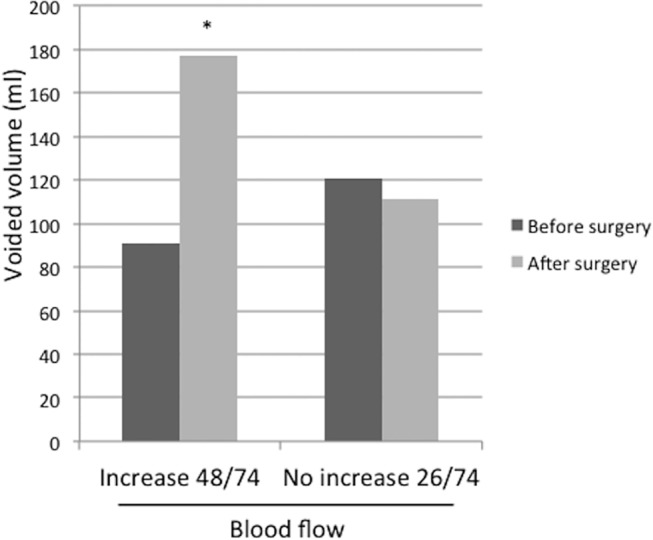
The change in voided volume.The change in voided volume is shown before and after surgery for both the increased perfusion group and the no change group. *: p<0.0001 Student’s t-test